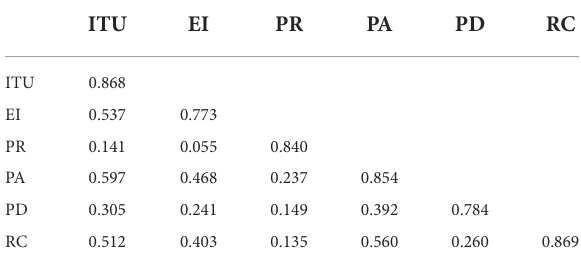
TABLE 5 Measurement of model discriminant